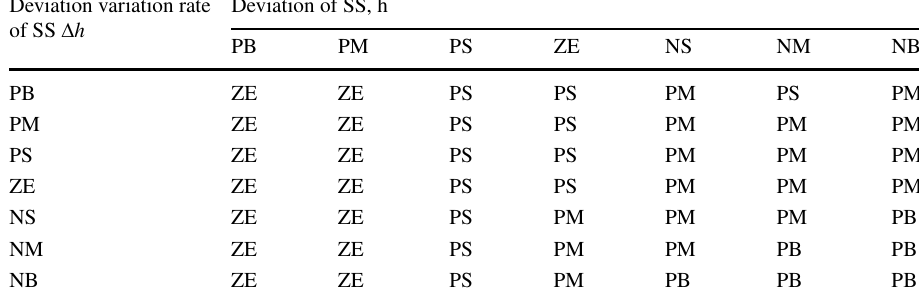
Table 2 PAM inverter output control